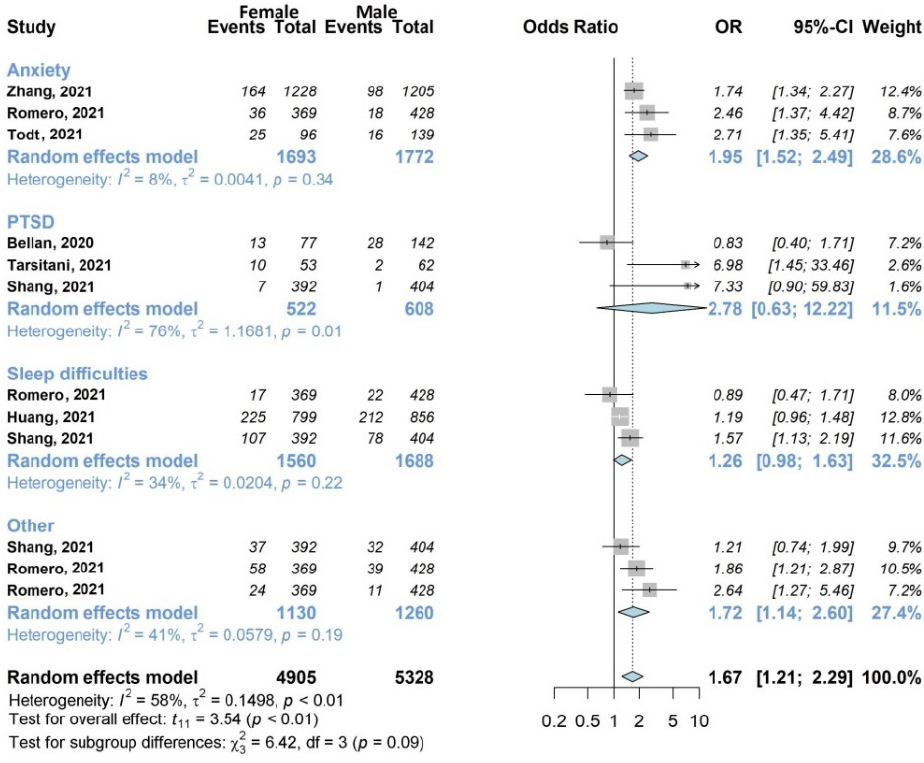
Figure 5. Forest plots of adjusted analyses for association between sex (female) and mental health. HKSJ, Hartung-Knapp-Sidik-Jonkman.